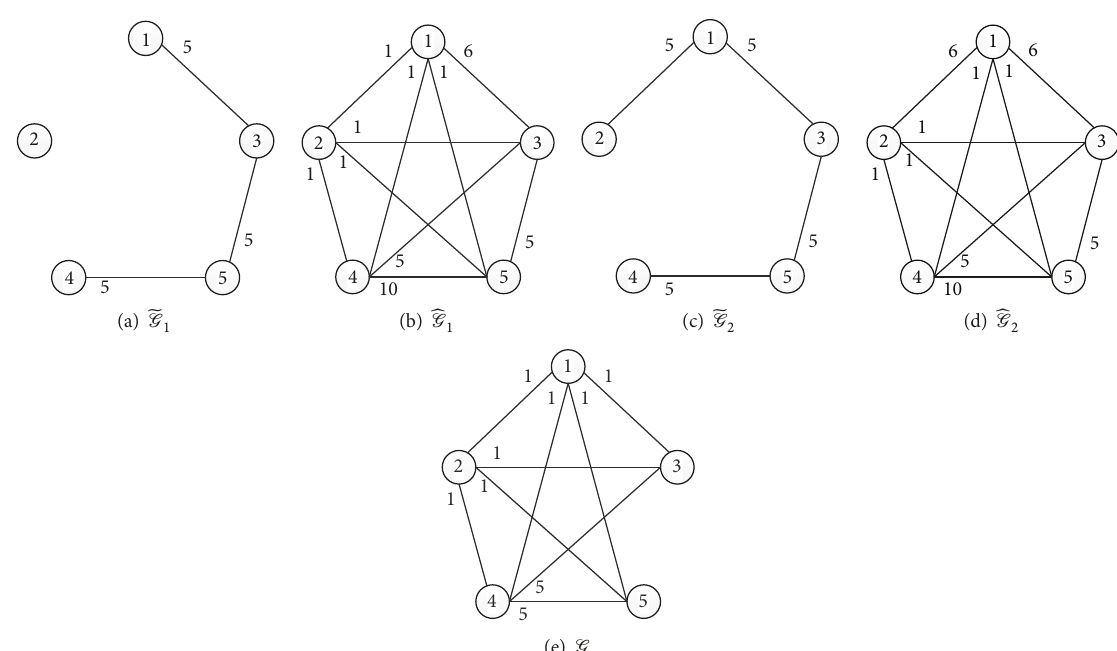
̃ G 1 ;(b)superposedsystem